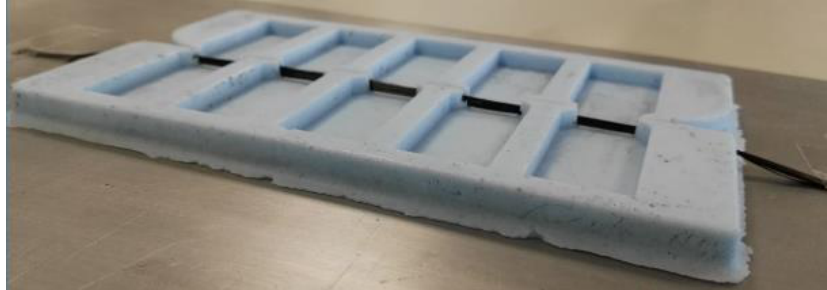
Figure 2. Fibers tensioned across silicon Iosipescu mould prior to resin injection.